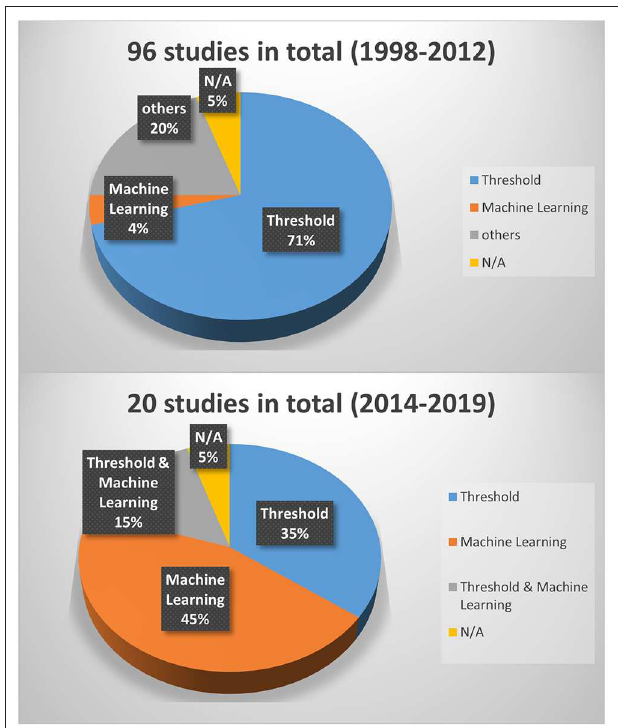
FIGURE 5 | Different types of methods used in fall detection using individual wearable sensors in the period 1998–2012 based on the survey of Schwickert et al. (2013) and in the period 2014–2020 based on our survey. The term “others” refers to traditional methods that are neither based on threshold nor on machine learning, and the term “N/A” stands for not available and refers to studies whose methods are not clearly